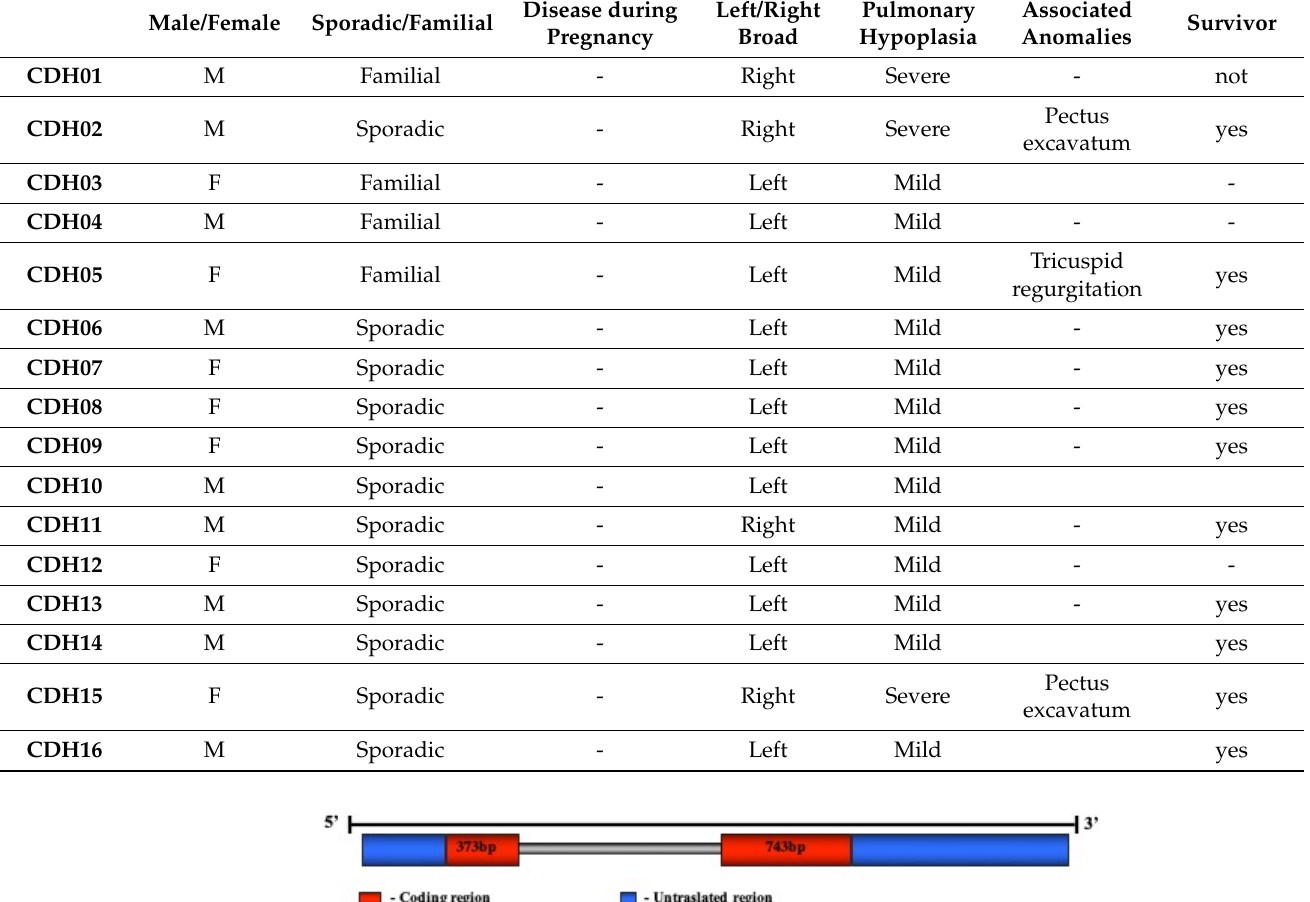
Figure 1. Exon II and III of TITF1 gene targeted for genetic screening. Table 2. Oligonucleotides for PCR and/or sequencing.